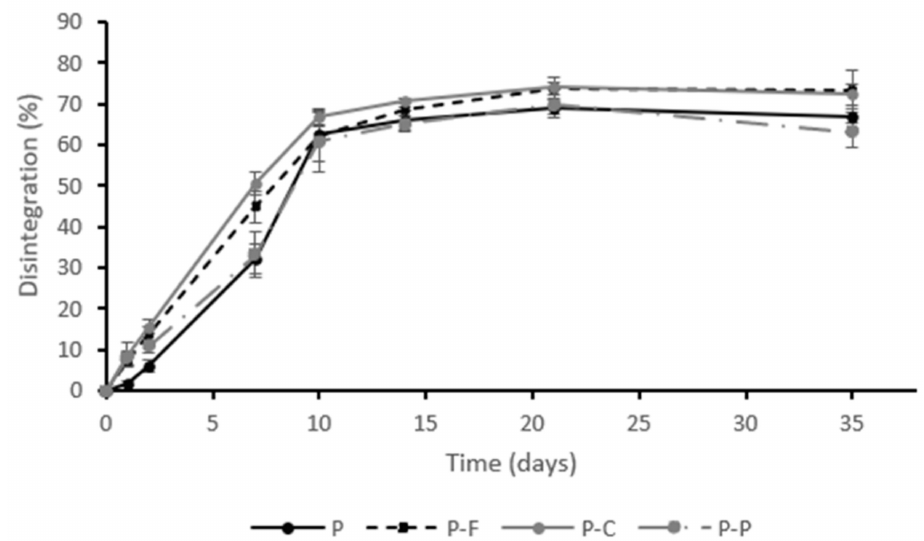
Figure 1. Development of sample disintegration as a function of time for the different films. PLA- PHBV blend films (P) and PLA-PHBV blend films containing ferulic acid (P-F), p -coumaric acid (P-C) and protocatechuic acid (P-P). Mean values and standard